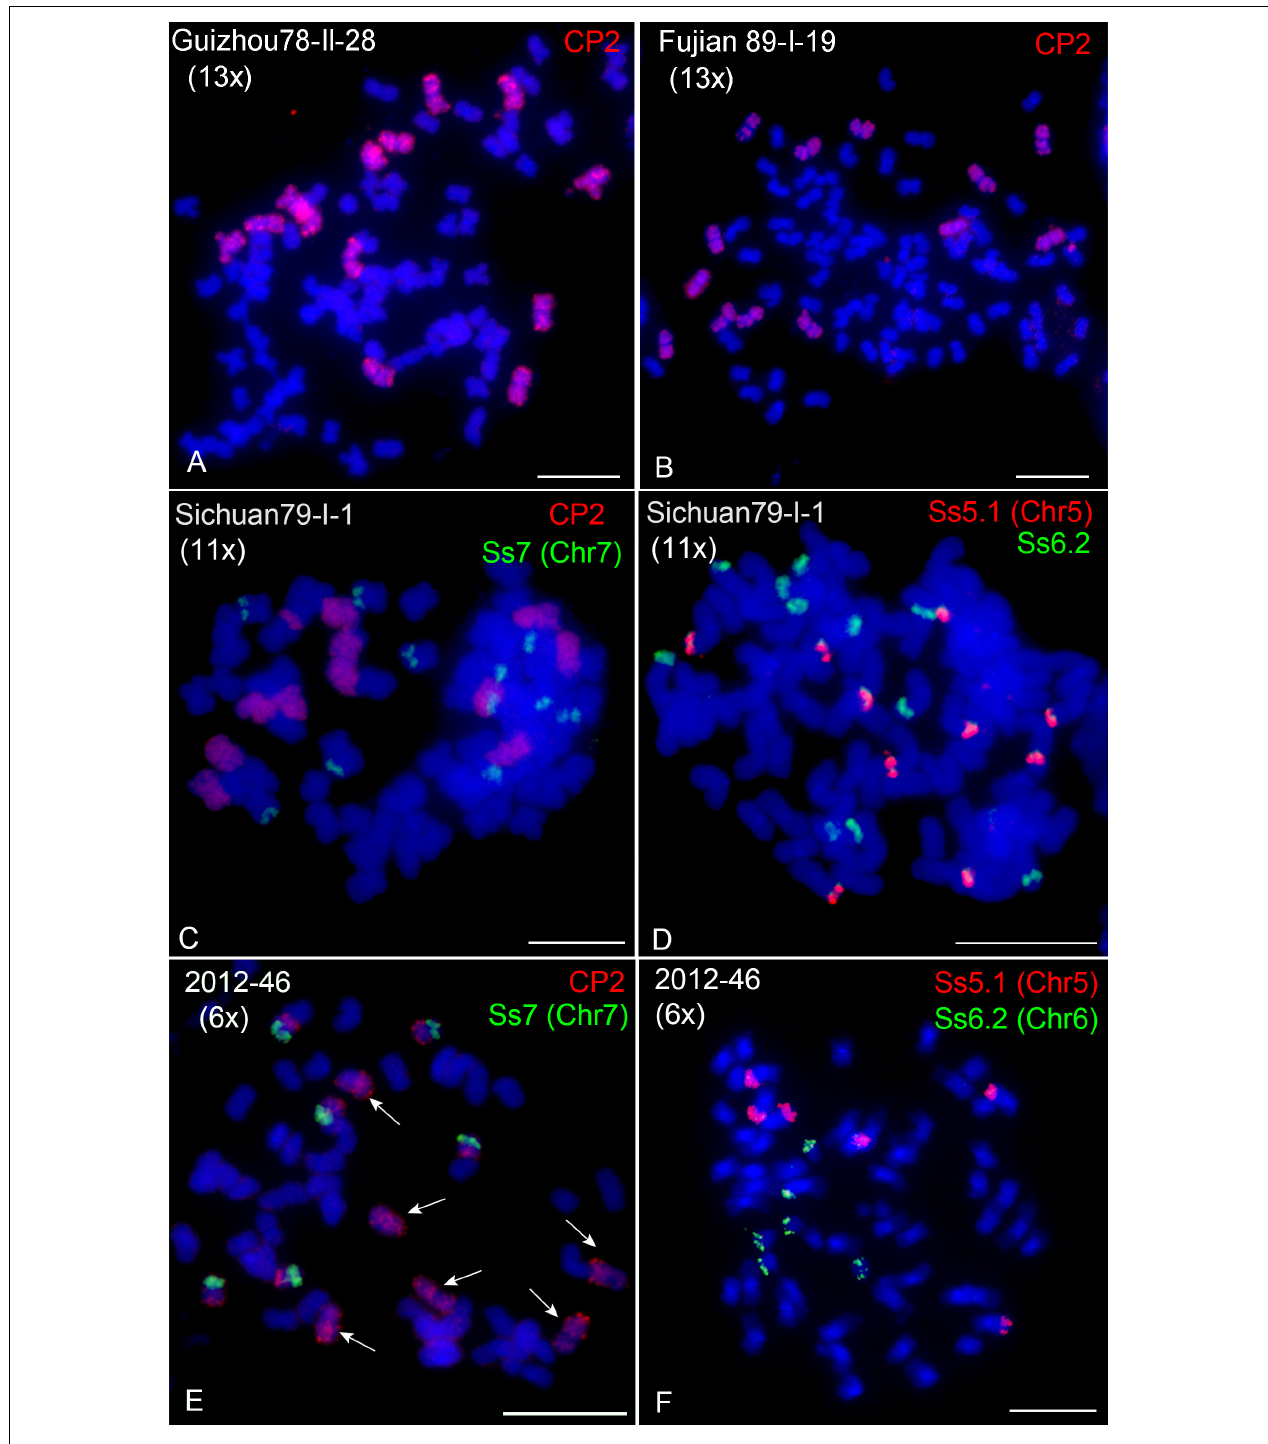
FIGURE 4 | FISH mapping in hexaploid, hendecaploid, and tridecaploid S. spontaneum clones. (A,B) CP2-FISH mapping in Guizhou78-II-28 (A) and Fujian89-I-19 (B) . (C) Dual-color FISH in the hendecaploid Sichuan79-I-1 using probes of CP2 (green) and the chromosome 7-specific probe Ss7 (red). (D) Dual-color FISH in the hendecaploid Sichuan79-I-1 using the chromosome 5-specific probe Ss5.1 (red) and chromosome 6-specific probe Ss6.2 (green). Ten and eleven signal copies of Ss5.1 and Ss6.2 were observed. (E) Dual-color FISH in the hexaploid 2012-46 using CP2 (green) and the chromosome 7-specific probe Ss7 (red). Arrows indicate the six copies of chromosome 2. (F) Dual-color FISH in the hexaploid 2012-46 using the chromosome 5-specific probe Ss5.1 (red) and chromosome 6-specific probe Ss6.2 (green). Scale bars, 10 µ m.